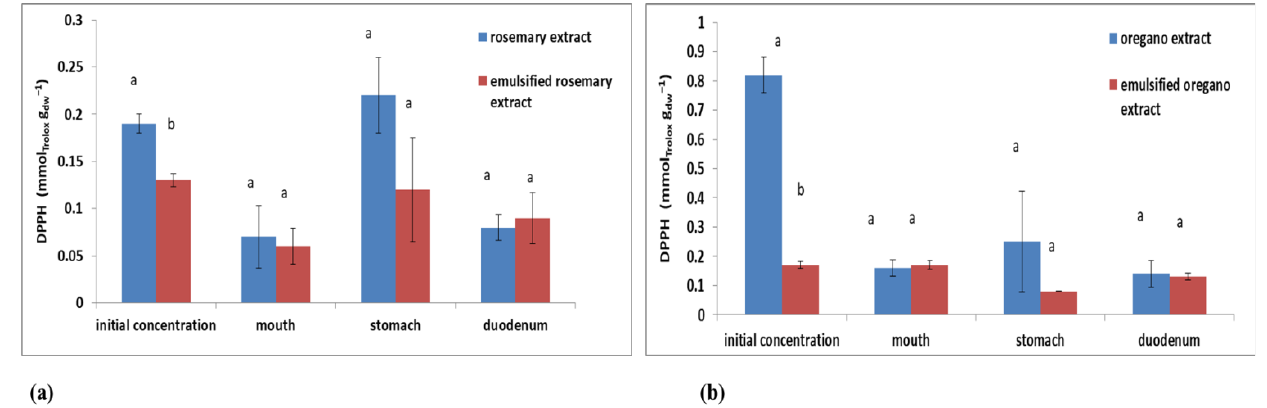
Figure 8. Changes in the antioxidant activity (DPPH) of plant extracts and oil-in-water emulsions containing extract during in vitro digestion for ( a ) rosemary and ( b ) oregano. Different letters above the columns represent significant differences at p <